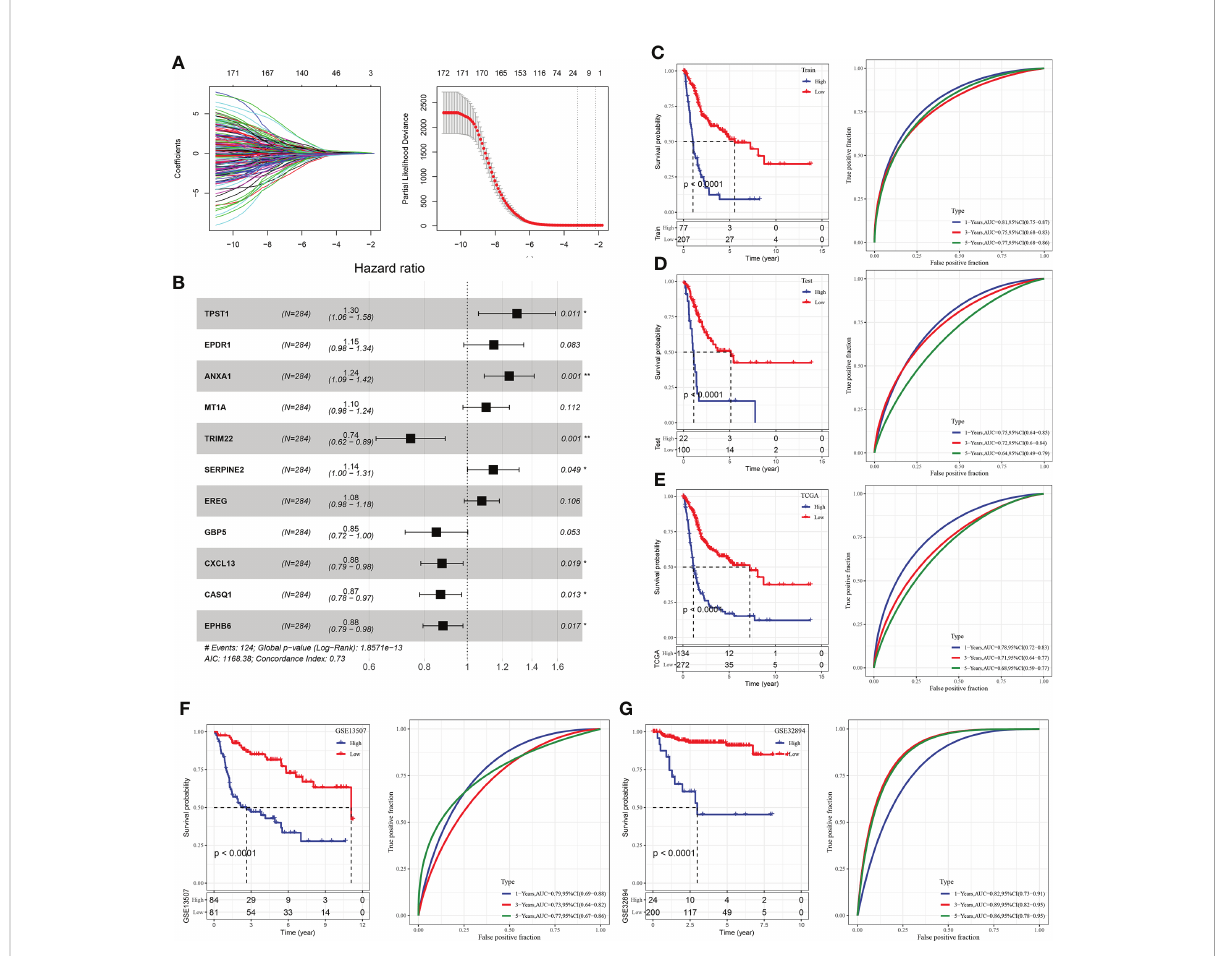
FIGURE 9 Construction of IRS model of BLCA. (A) Lasso coef fi cient distribution of 40 prognostic RNAs in the GEO training cohort. According to the logarithm ( l ) sequence plotting coef fi cient pro fi le. (B) Multifactor results of genes in the fi nal IRS model; (C) KM and ROC analysis of IRS model on GEO training dataset. (D) KM and ROC analysis of IRS model on GEO validation dataset. (E) KM and ROC analysis of IRS model on all GEO datasets. (F) KM and ROC analysis of IRS model on all TCGA datasets. (G) KM and ROC analysis of IRS model on all ICGC datasets. *P<0.05,